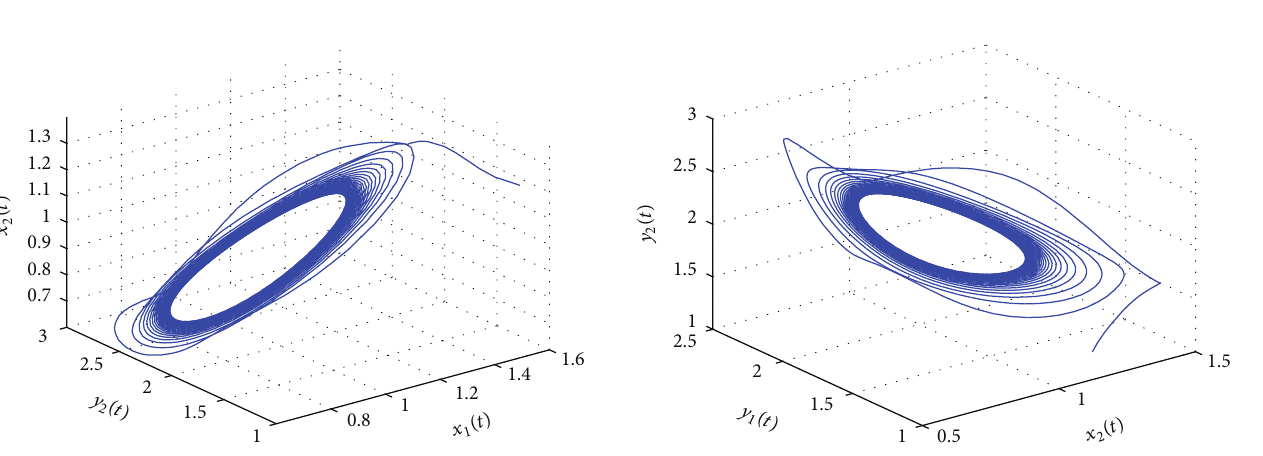
Figure 24: The phase plot of the states 𝑥 2 , 𝑦 1 , 𝑦 2 for 𝜏 2 = 7.5000 > = 6.6494 and 𝜏 ∗ = 2.5000 𝜏 ∗ 2 1